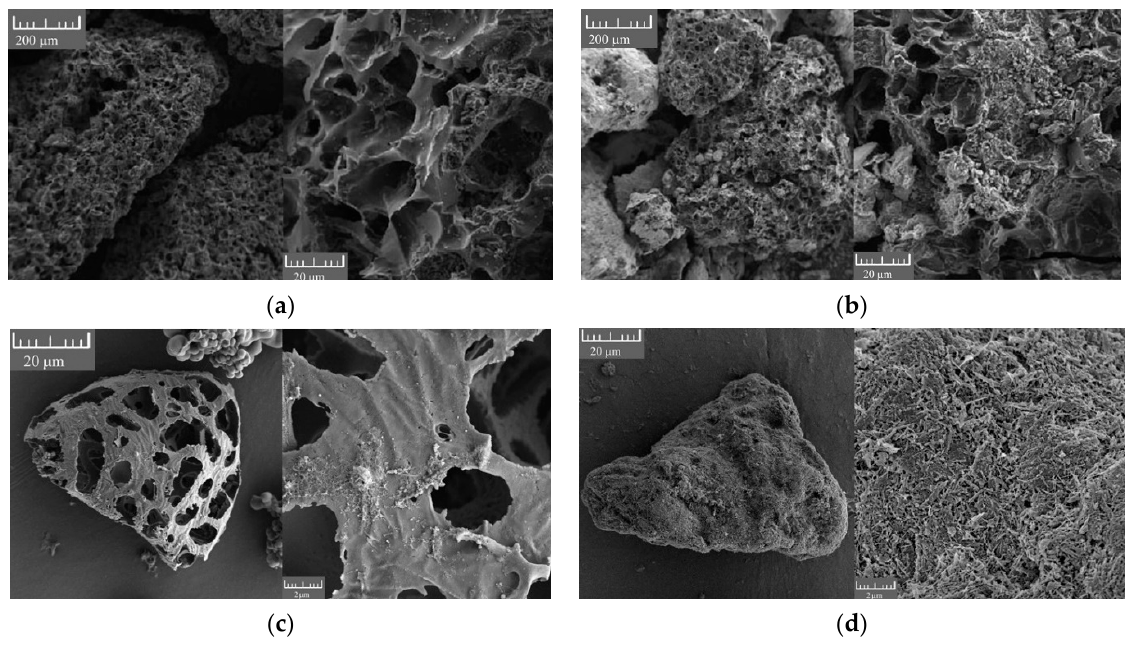
Figure 5. SEM images of pyrolyzed and hydrothermally carbonized avocado pits with and without the addition of 20 wt% Fuller’s Earth: ( a ) avocado pyrolyzed at 600 °C (scale bar left image = 200 µm, right image = 20 µm); ( b ) avocado + Fuller’s Earth pyrolyzed at 600 °C (scale bar left image = 200 µm, right image = 20 µm); ( c ) avocado hydrothermally carbonized at 250 °C (scale bar left image = 20 µm, right image = µm); ( d ) avocado + Fuller’s Earth hydrothermally carbonized at 250 °C (scale bar left image = 20 µm, right image = 2 µm).